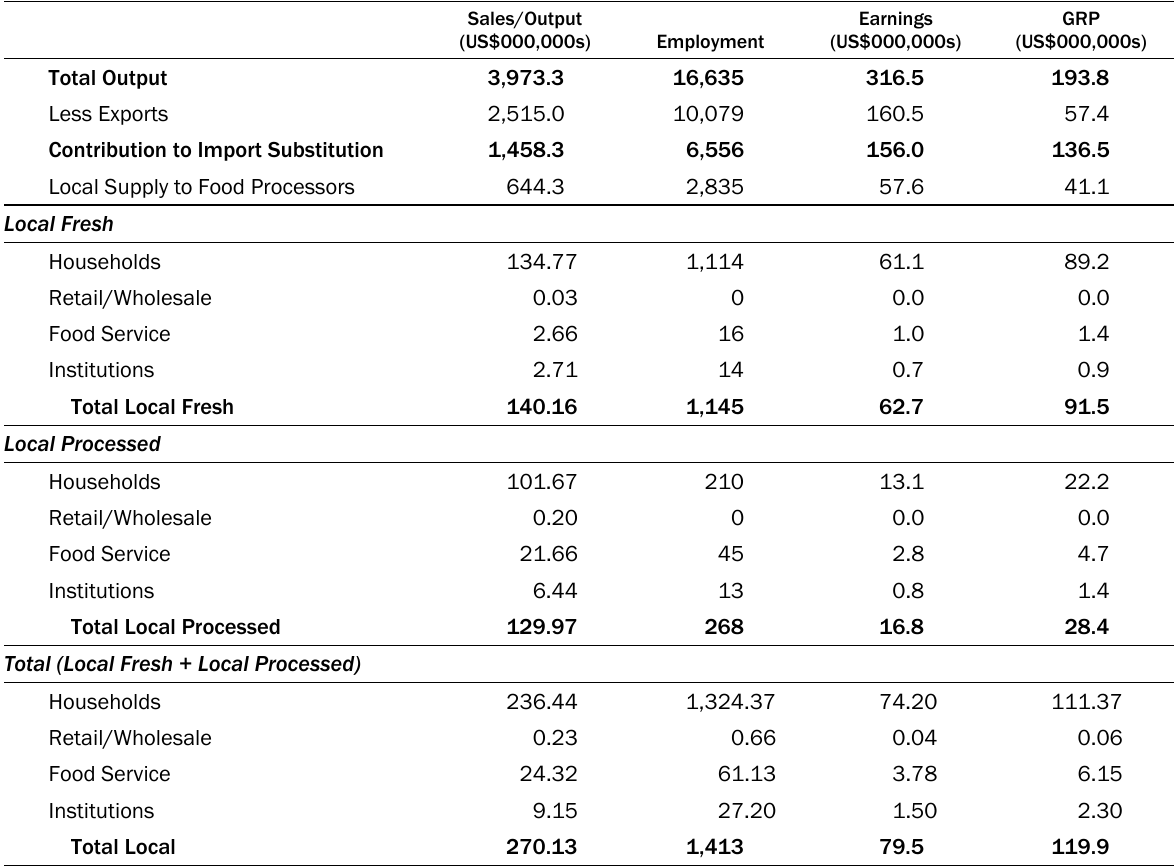
Table 2. Estimated Baseline Local Foods